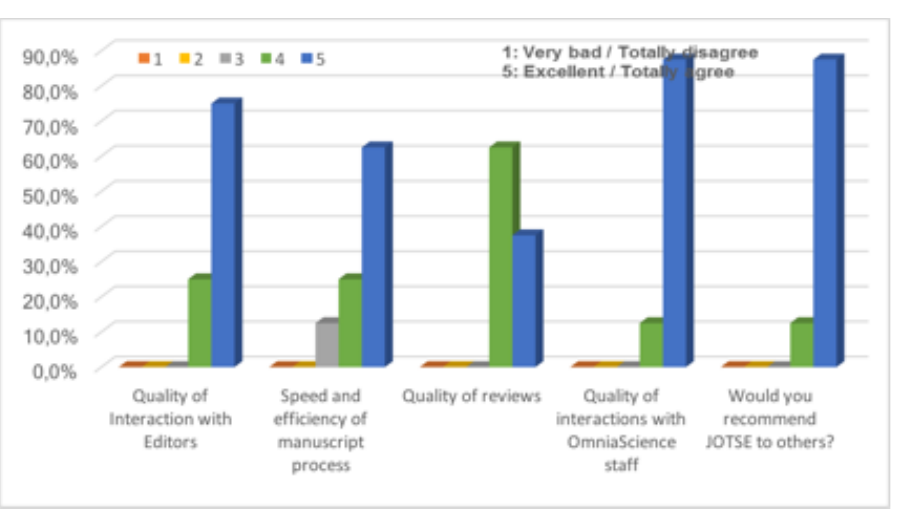
Figure 2. JOTSE author survey results